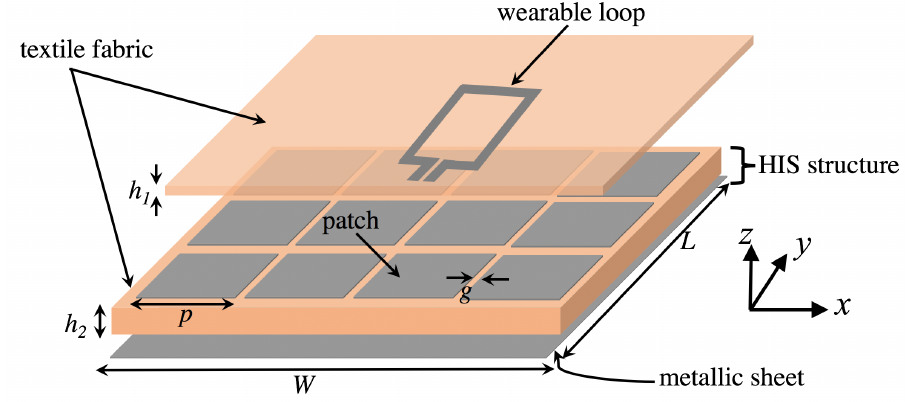
Figure 14. Schematic of the wearable loop antenna with high-impedance surface (HIS) structure.